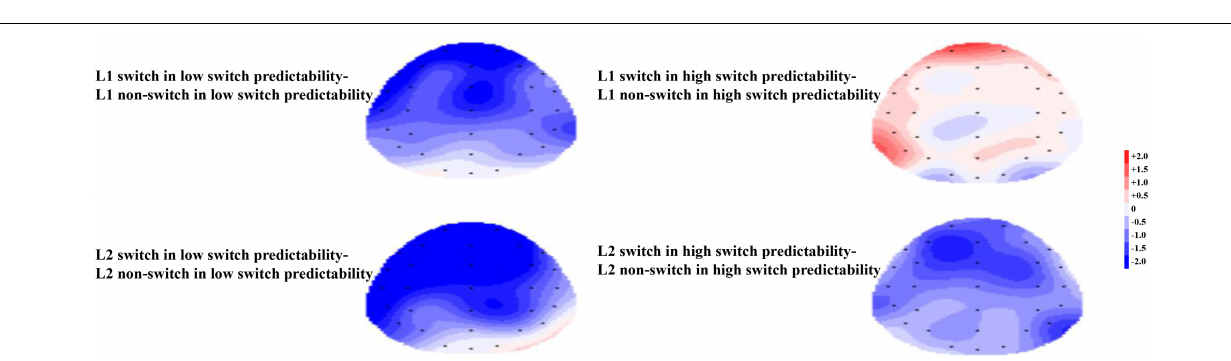
FIGURE 8 | (Left) For the low switch predictability condition, the topographical maps of the late phase for the distribution of the difference between the same language in different transition trials, i.e., switch trials minus non-switch trials. (Right) For the high switch predictability condition, the topographical maps of the late phase for the distribution of the difference between the same language in different transition trials, i.e., switch trials minus non-switch